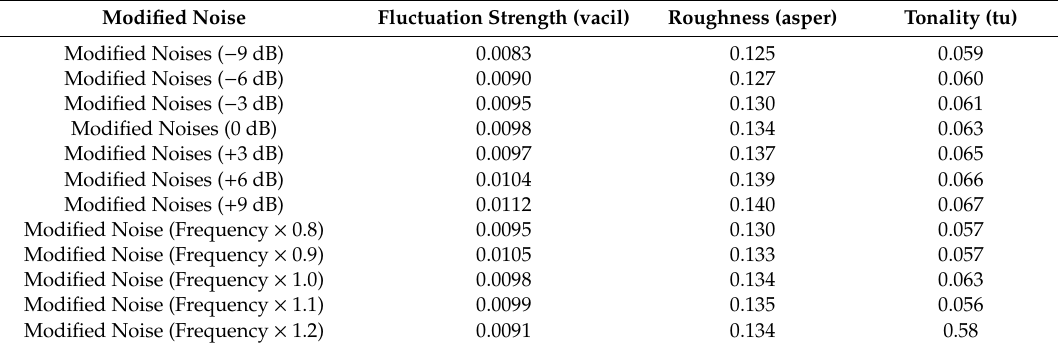
Table 7. Fluctuation strength of modified slug noises.